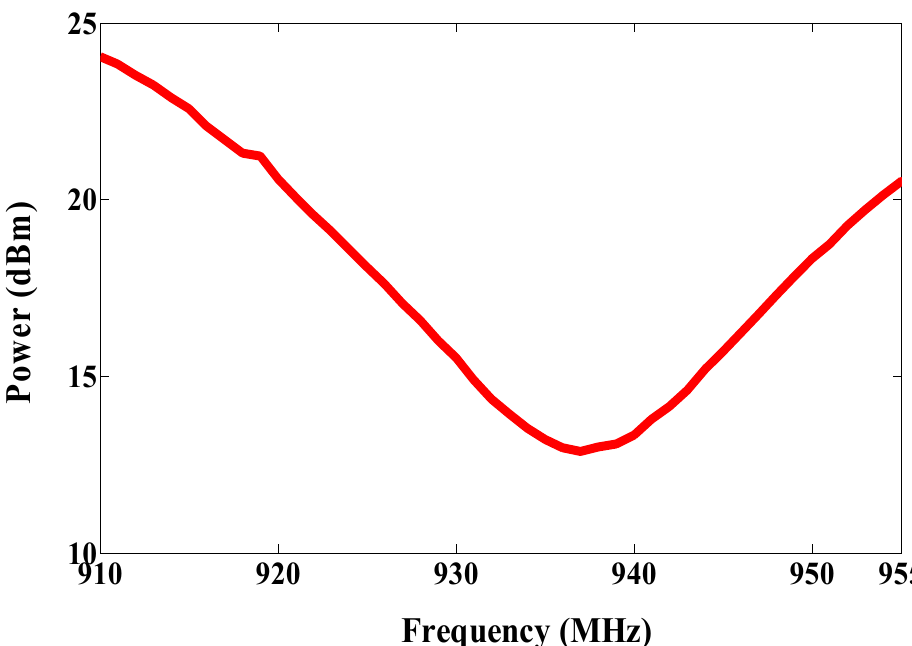
Figure 8. Measured minimum required power for activating antenna A RFID chip.